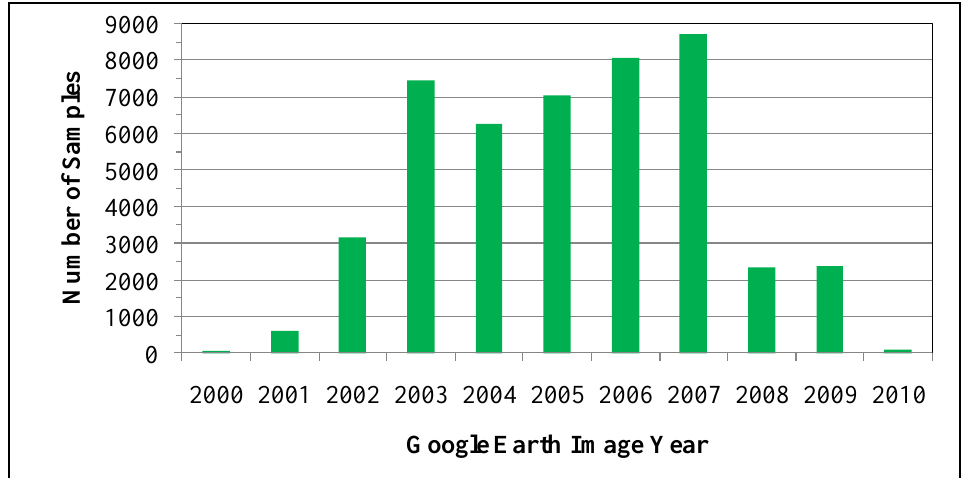
Figure 6. Distribution of sampled Google Earth images by year within Latin America and the Caribbean.